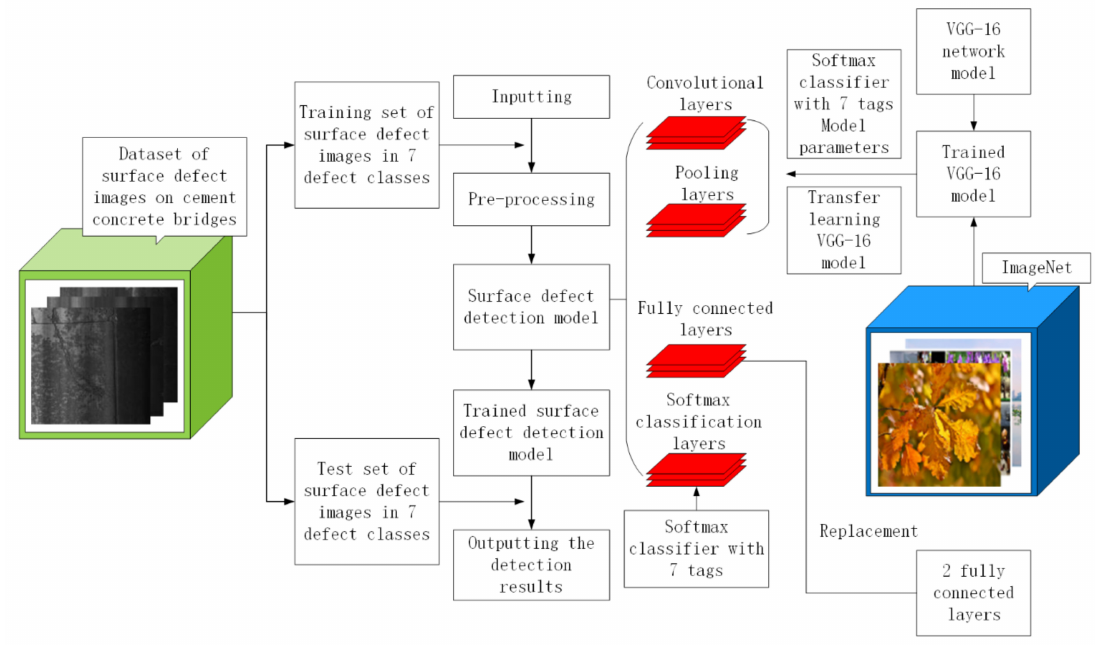
Figure 10. Experimental